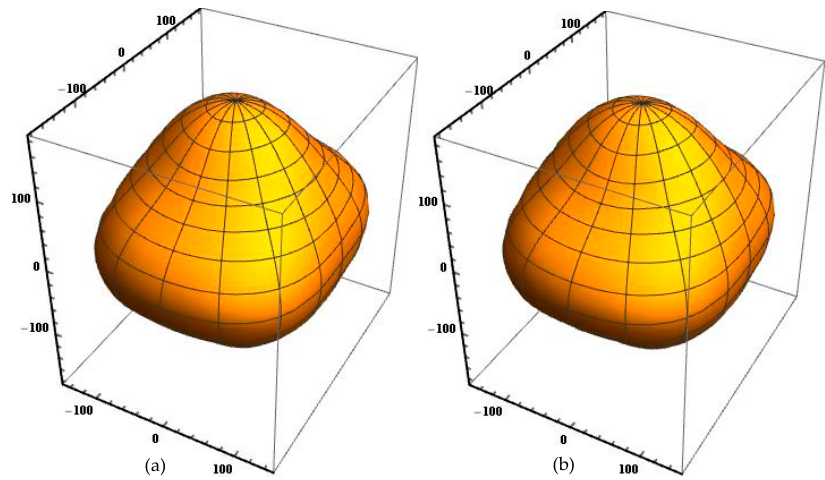
Figure 1. The orientation dependent Young’s modulus of B19 TiAl using the elastic constants obtained from the energy density ( a ) and the strain–stress ( b ) methods. Crystals 2017 , 7 , 39